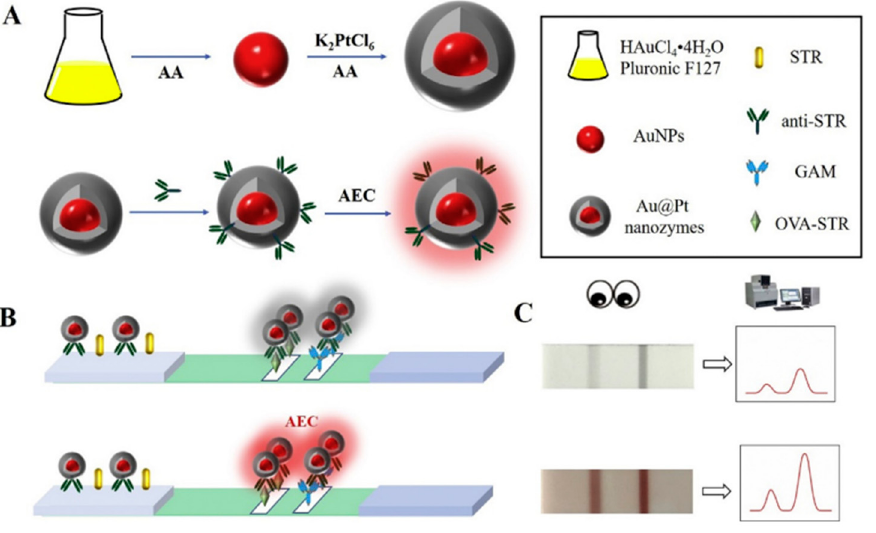
Figure 5. Schematic illustration for the colorimetric lateral fl ow immunoassay (LFA) based on Au@Pt [157] (Reproduced with permission from Elsevier Ltd.). from Elsevier